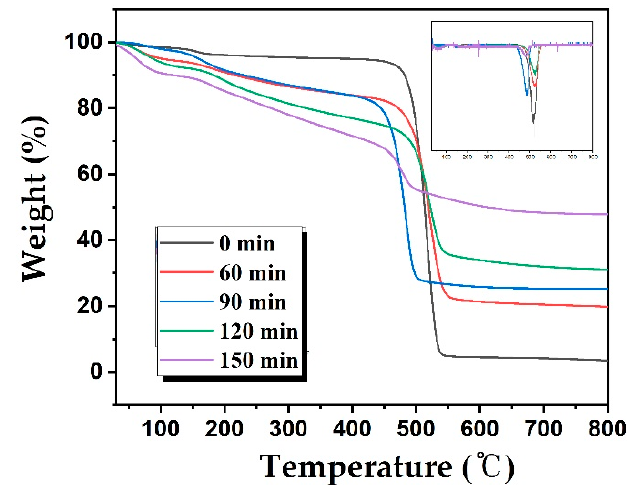
Figure 8. TGA results of the sulfonated LDPE/HDPE sheath-core fibers for various crosslinking times at 130 °C. The inset is corresponding differential curves for various crosslinking times at 130 °C.